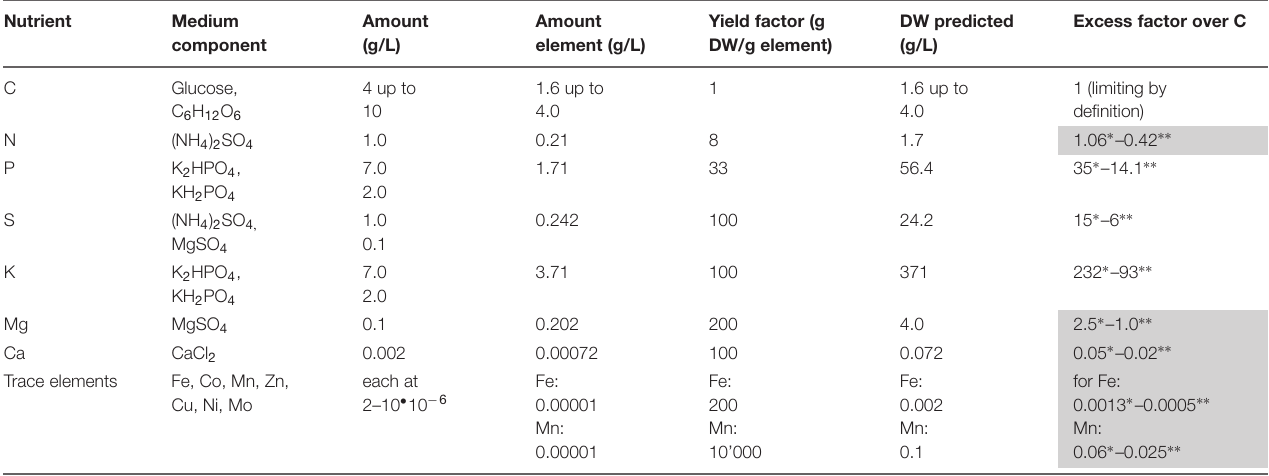
TABLE 2 | Composition and analysis of defined minimal medium M9, which is regularly employed for carbon/energy-limited cultivation of Escherichia coli strains with glucose or other carbon/energy sources. Nutrient Medium